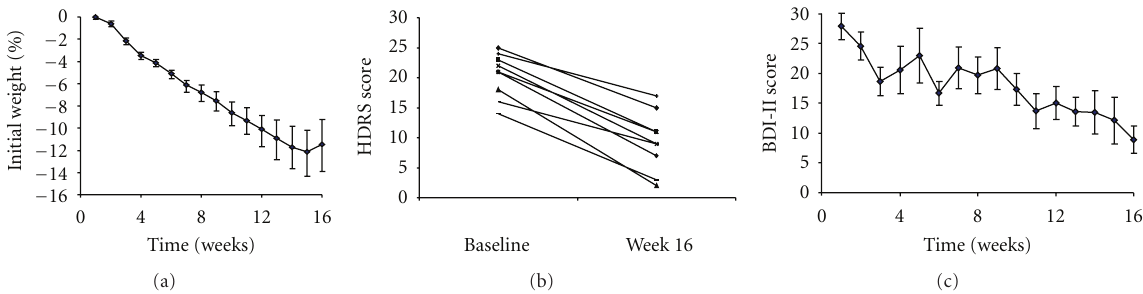
Figure 1: (a) shows mean change in percent of initial weight over 16 weeks of treatment ( n = 9). (b) presents changes in HDRS scores for each participant from baseline to week 16 ( n = 9). (c) shows mean change in BDI-II score over 16 weeks of treatment ( n = 9).